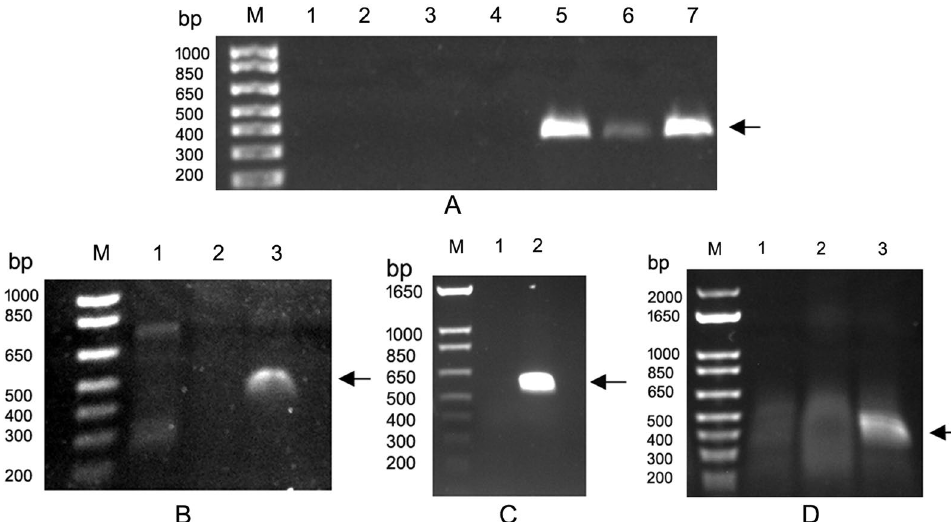
Figure 3. Detection of viruses identified from alfalfa samples collected from production fields in the U.S. Pacific Northwest in 2019/2020 using RT-PCR. ( A ) RT-PCR detection of cherry virus Trakiya, alfalfa strain. Lanes 1–4, negative PCR reactions; Lanes 5–7, PCR products amplified from different alfalfa leaves infected with CVT-A using primer pair LN882/883. ( B ) RT-PCR detection of hop latent virus using primers LN850/ LN851. Lanes 1 and 2, negative samples. Lane 3, alfalfa sample infected with HLV. ( C ) RT-PCR detection of potato virus X using primers LN78/LN79. Lane 1, negative sample. Lane 2, PVX-infected sample. ( D ) RT-PCR detection of alfalfa nucleorhabdovirus 1 using primers LN846/LN847. Lane 1 and 2, negative reactions. Lane 3, a 437 bp RT-PCR product amplified from infected alfalfa leaves. M, 1 kb plus DNA ladder (Thermo Fisher Scientific, Waltman, MA USA). Arrows indicate amplified PCR products. Original full-length images of the gels are presented in the Supplementary Figure